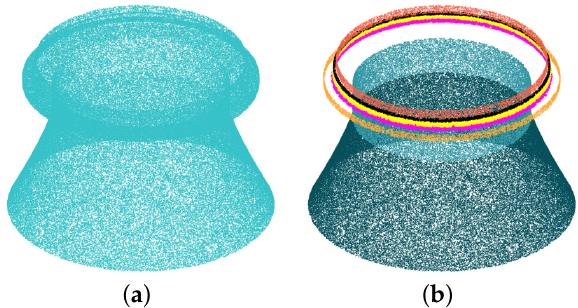
Figure 7. Point cloud segmentation. ( a ) The initial state of the point cloud. ( b ) The result of point cloud